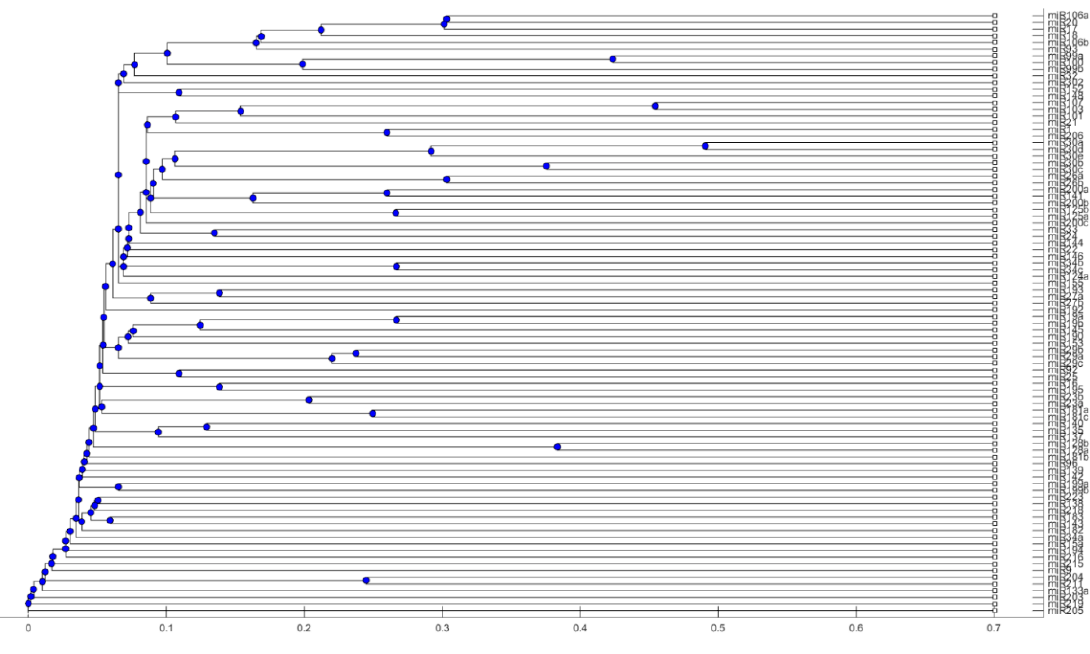
Figure 3. Phylogenetic tree of 90 miRNAs.